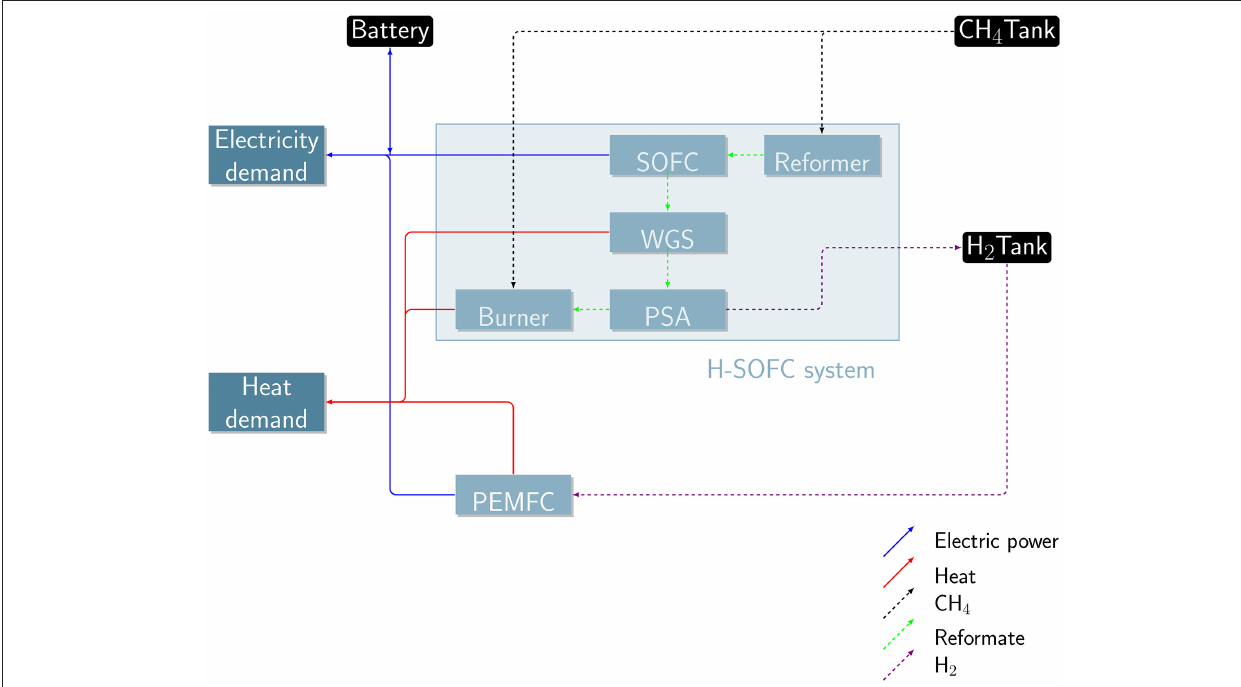
FIGURE 1 | Graphical representation of the proposed energy